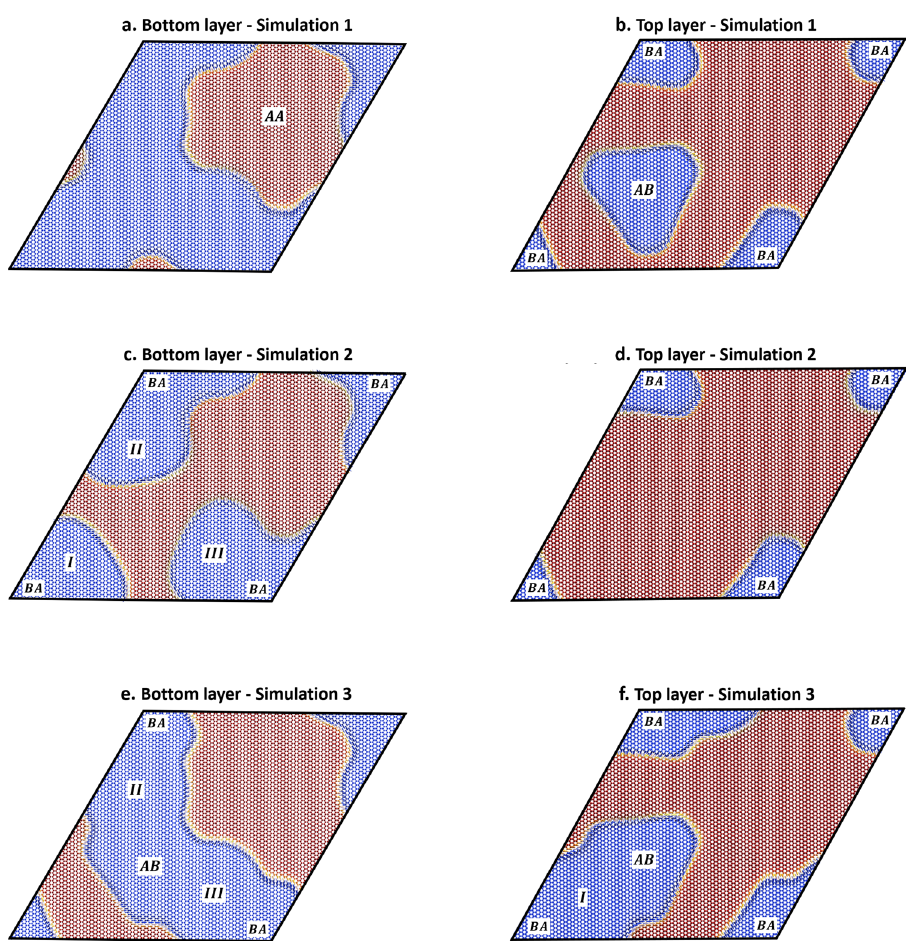
Fig. 3 Dependence of the spontaneous topological spin textures (TSTs) on the initial spin con fi guration. An illustrative example of distinct topological ground states obtained from different initial random con fi gurations in the Heisenberg model with twist angle θ ¼ 0 : 89 (cid:2) and external magnetic fi eld strength B ¼ 0 T . Simulation 1 results in a TST with topological charge Q ¼ (cid:3) 2 in the ferromagnetic (FM) AA region of the bottom layer ( a ). Meanwhile, the top layer ( b ) hosts a trivial magnetic bubble in the FM BA region and a TST ( Q ¼ (cid:3) 1) in the FM AB region. In simulation 2, the bottom layer ( c ) displays a single TST ( Q ¼ 1) that extends over the monoclinic regions I, II, III, and the FM region BA. The top layer ( d ) hosts a TST ( Q ¼ 1) in the BA region. Simulation 3 results in a magnetic strip in the bottom layer ( e ) and a TST ( Q ¼ (cid:3) 2) combining FM regions AB, BA, and the monoclinic region I ( f ). To better visualize the reported TSTs, we present the same results duplicated over a 2 × 2 moiré superlattice in Supplementary Fig.